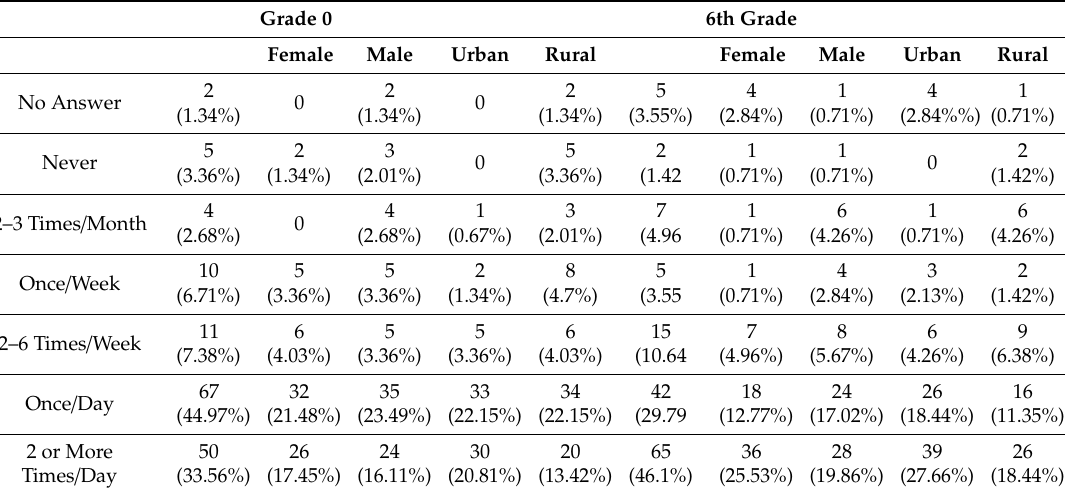
Figure 6. Differences in the reason for visits to the dental practice for the last year, according to residence. Table 6. Teeth cleaning